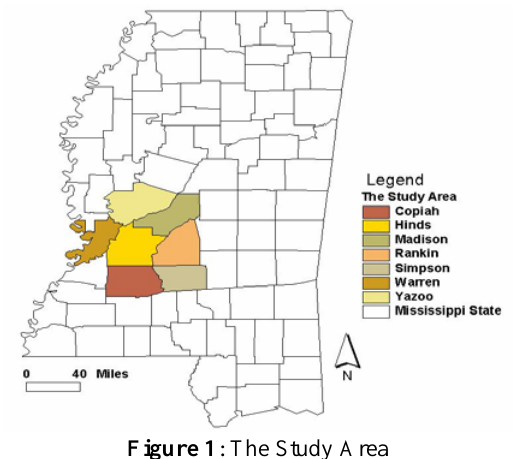
Figure 1 : The Study